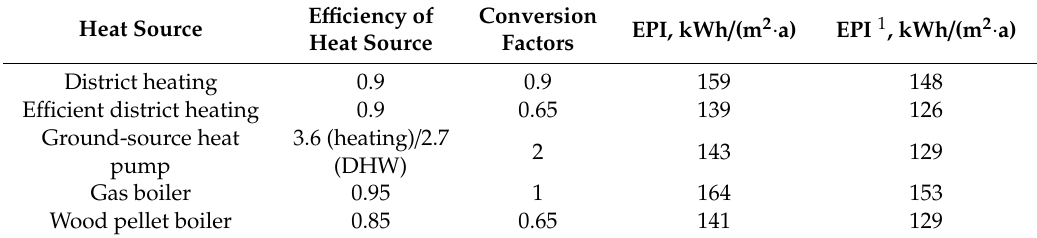
Table 5. Energy performance of the BC with di ff erent heat